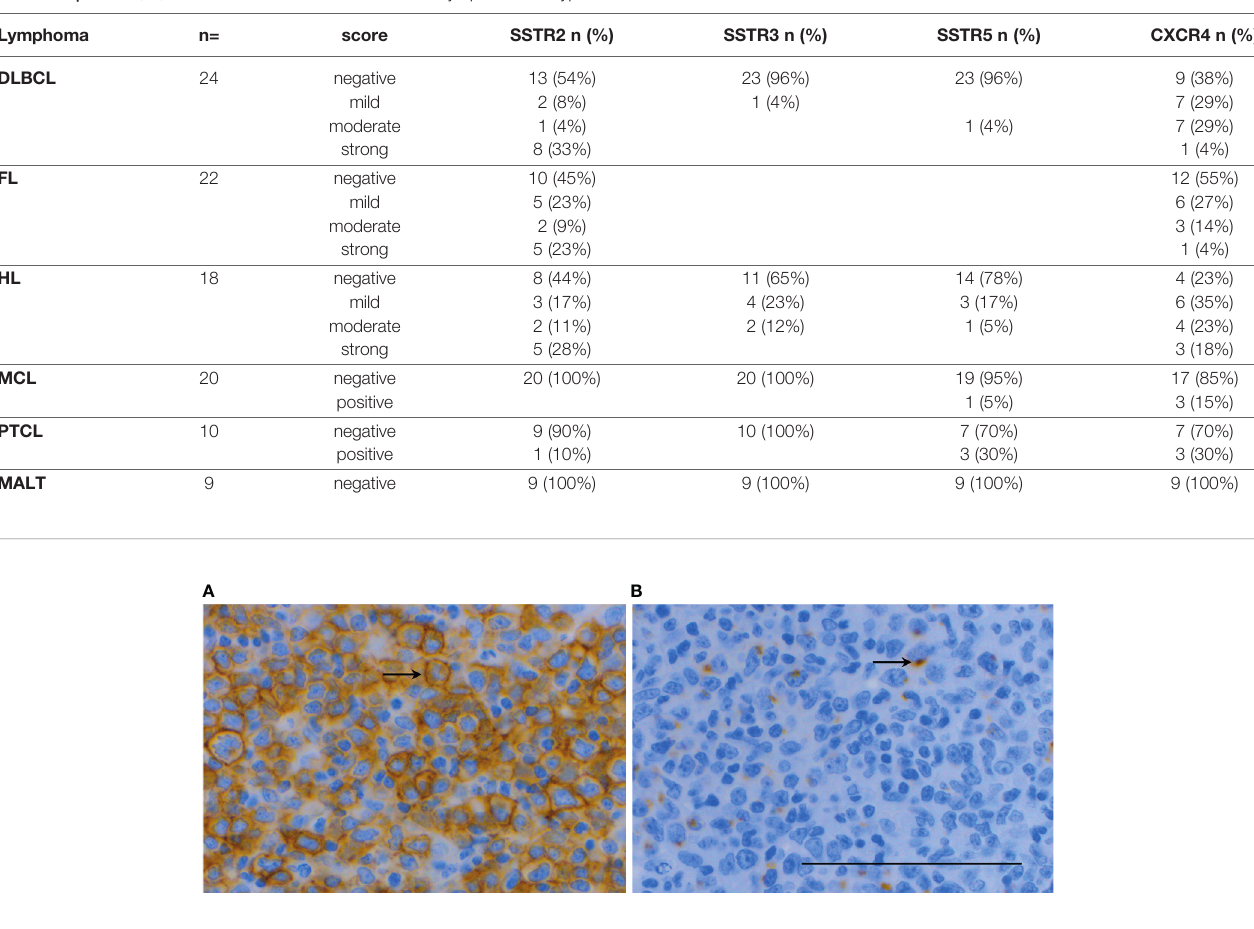
FIGURE 2 | SSTR2 IHC (A) showed strong (score 3) immunopositivity on the cell membrane of malignant cells (arrows) in a patient with DLBCL of GCB-type (no. 35) with mild-to-moderate (score 1-2) cytoplasmic dot-like co-expression of CXCR4 (B) indicating to internalization of the receptor. Scale bar=100